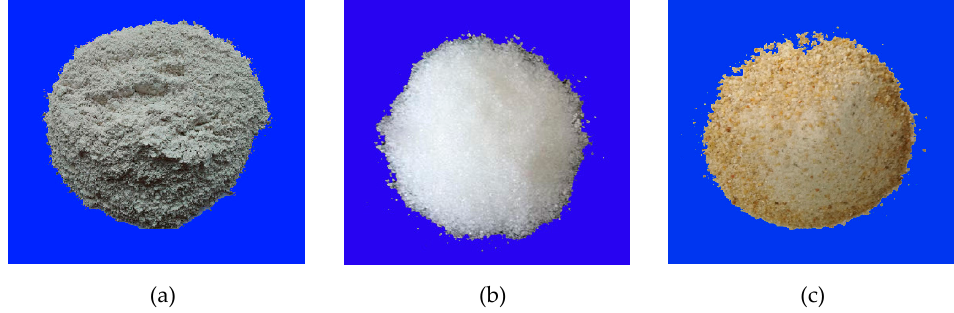
Figure 1. The raw materials: ( a ) Portland cement; ( b ) polyvinyl alcohol (PVA) power, ( c ) standard sand.